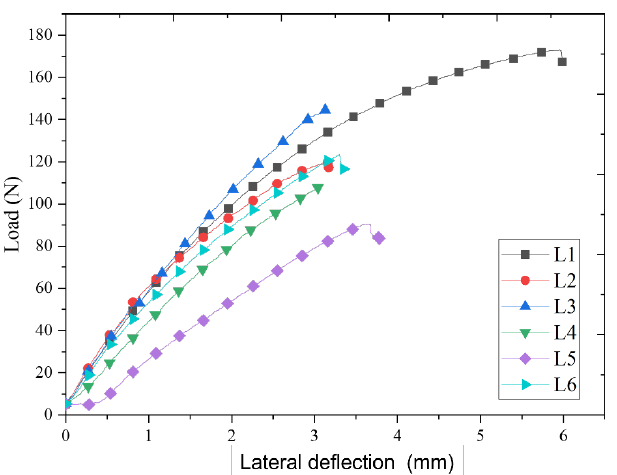
Figure 8. Flexural strength of laminates subjected to three point bending test.